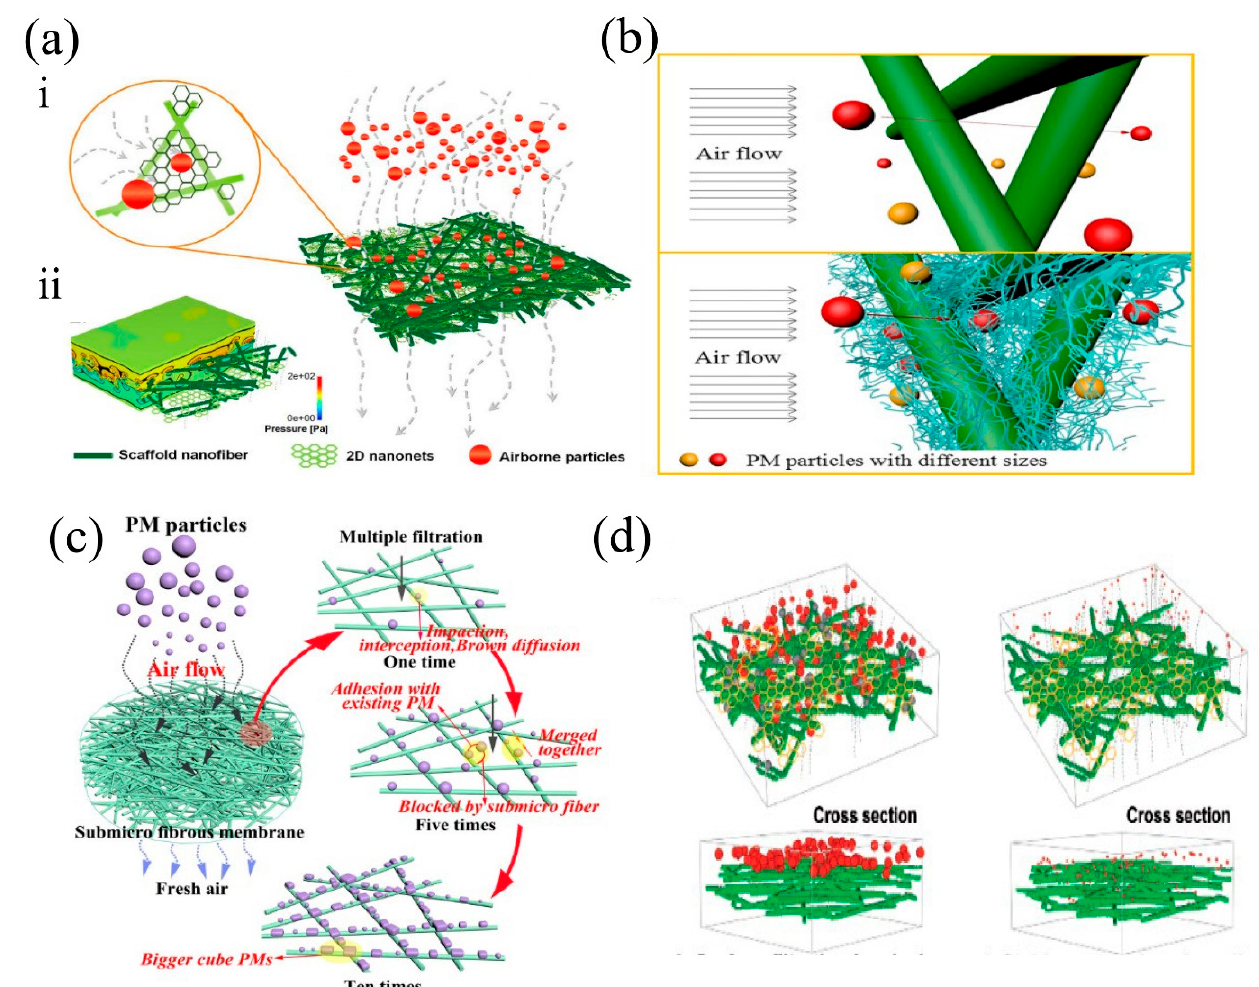
Figure 8. ( a ) 3D model illustrating the filtration process of PMIA NF/N membrane for 300–500 nm particles by physical sieving and surface filtration: ( ⅰ ) absolute removal manner and ( ⅱ ) robust air permeability. Reprinted with permission